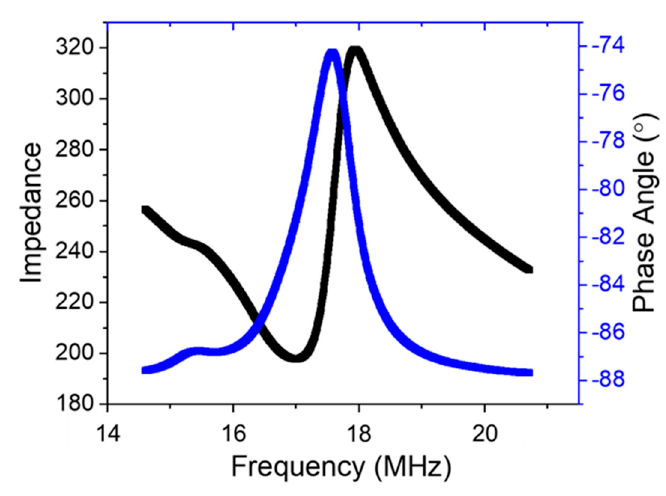
Figure 8. Impedance spectra of PZT–polymer 2-2 composite containing 32 elements.